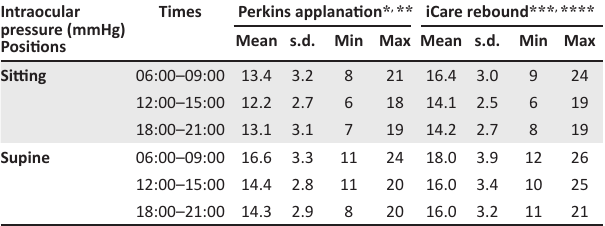
TABLE 1: Averages, standard deviations and intraocular pressure ranges (mmHg) with the two devices. Intraocular Times pressure (mmHg) Positions